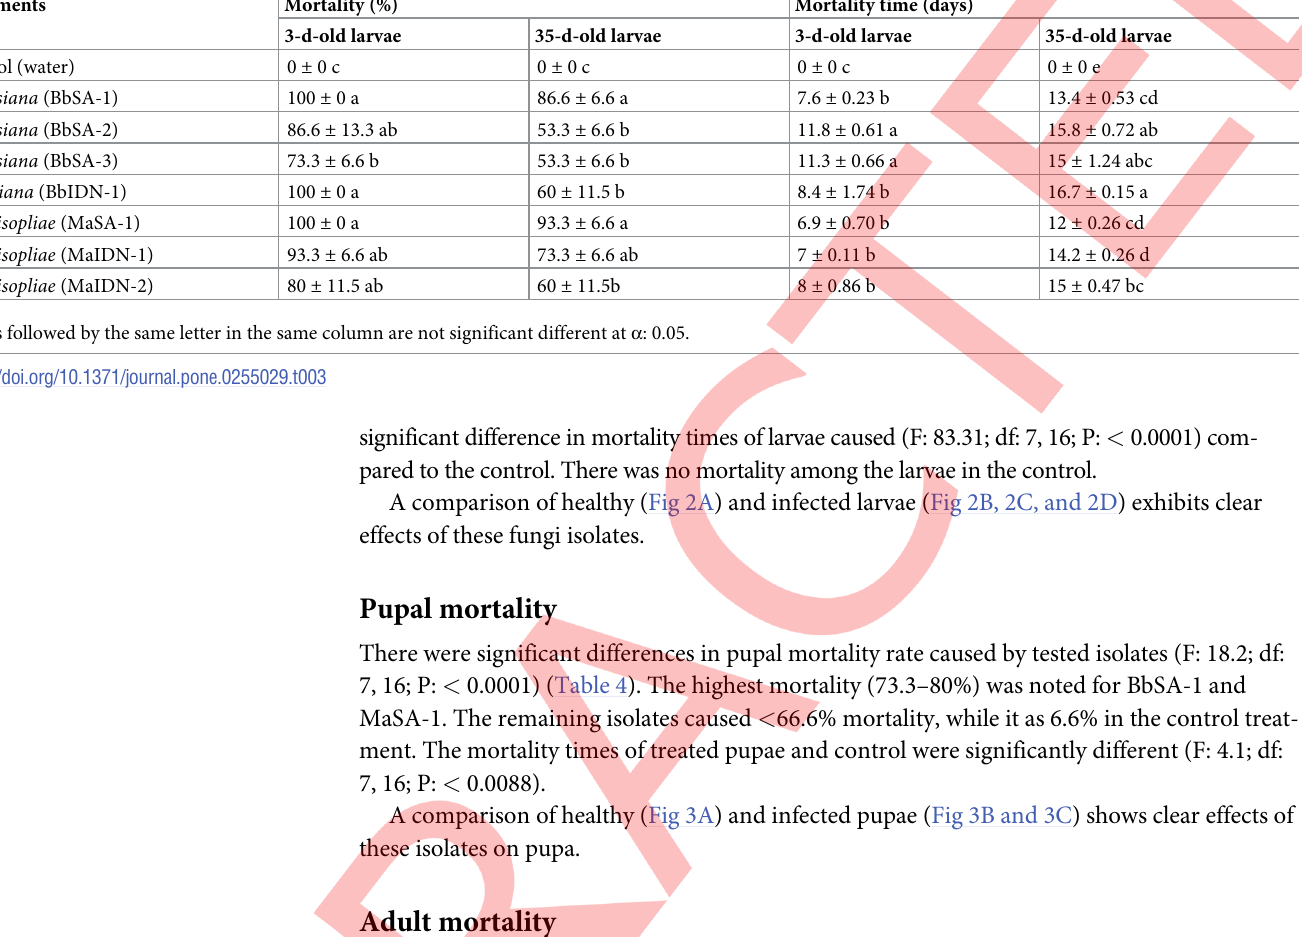
Table 3. Mean mortality (% ± SE) of 3 and 35 days old larvae of red palm weevil treated with Metarhizium anisopliae and Beauveria bassiana under laboratory conditions.